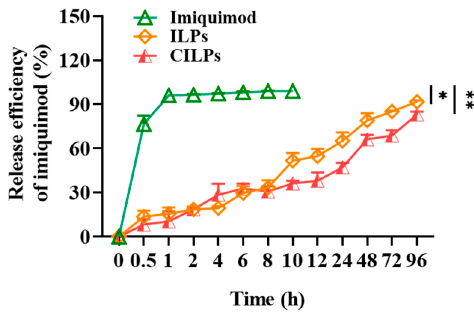
Figure 3. Imiquimod release curves of the free imiquimod, ILPs, and CILPs in PBS at 37 °C. Data are presented as means ± standard deviation ( n = 3). * p < 0.05, ** p < 0.01.